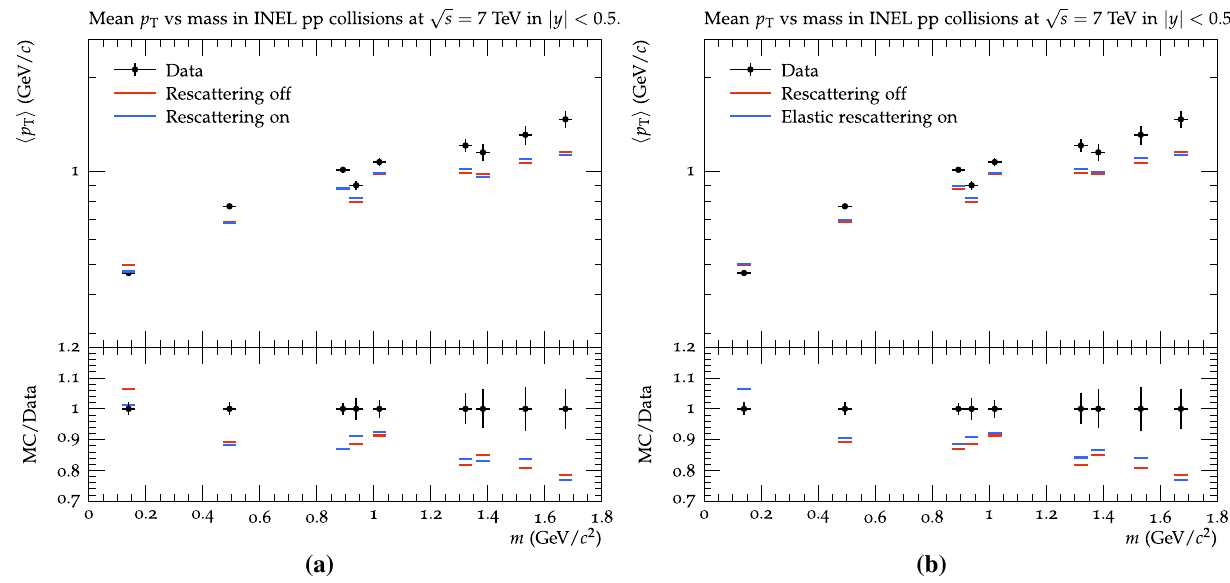
Fig. 16 Average p ⊥ for different particle species, ordered by mass, with data from ALICE [4,8]. The included particles are π ± , K ± ,